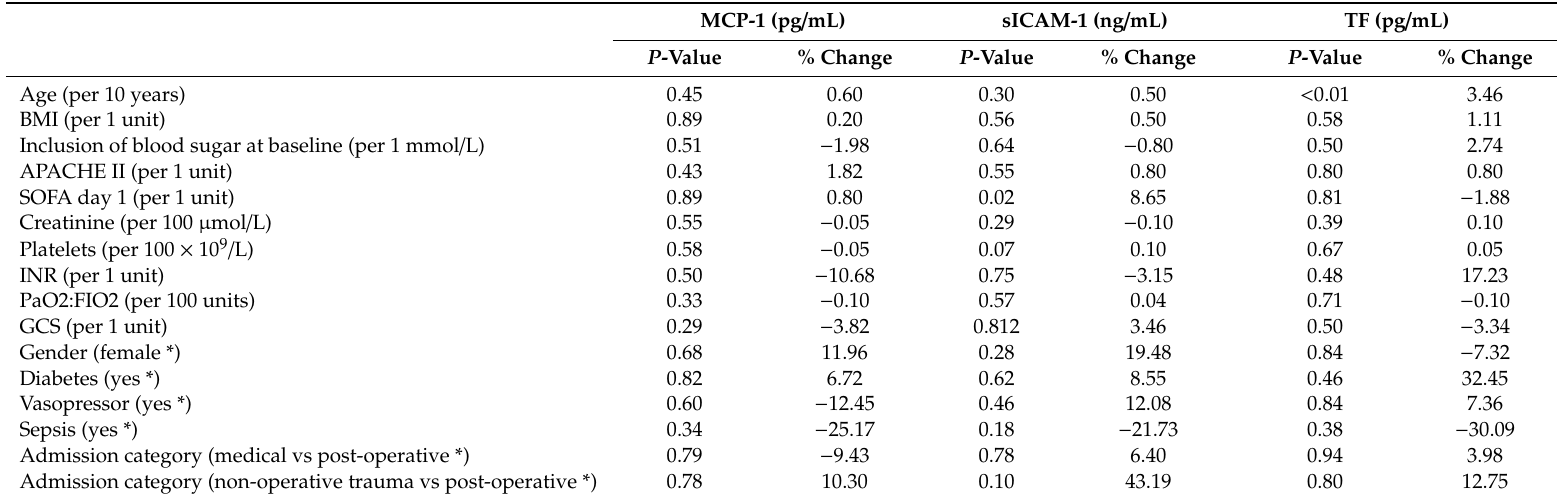
Table 3. Predictors of the biomarkers (TF, MCP-1, and ICAM-1) at baseline using a multiple linear regression